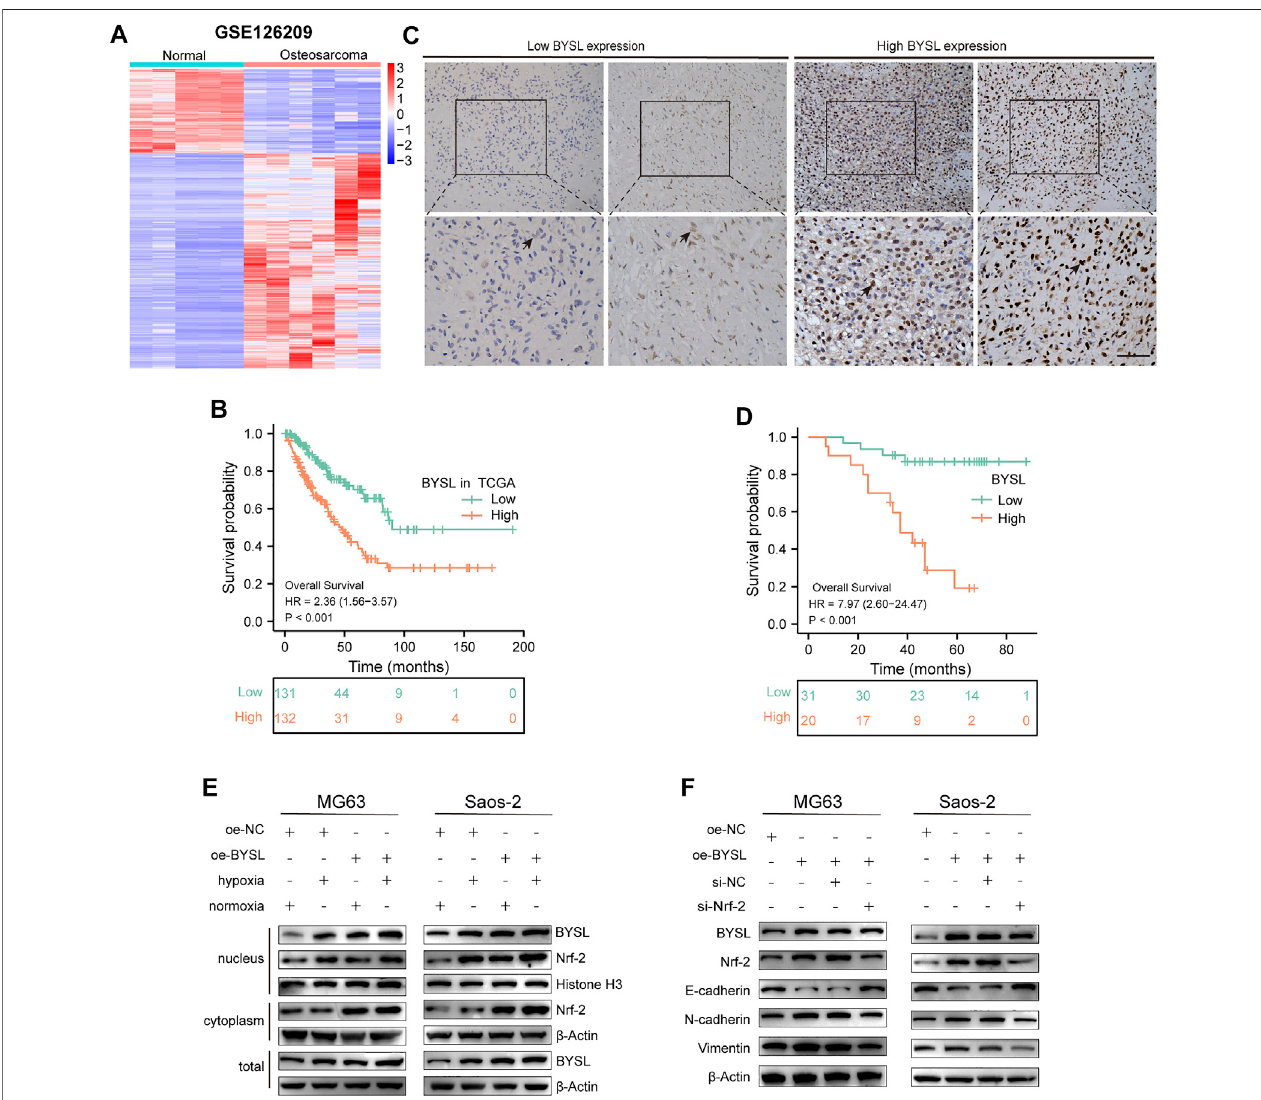
FIGURE1 | BYSL is related to thepoor prognosisof patients with osteosarcoma. (A) Cluster heatmap ofdifferentially expressed genesin GSE126209. (B) Overall survival was compared between osteosarcoma patients with high and low BYSL expression in TCGA database. (C) Immunocytochemical staining of BYSL in osteosarcomatissues( n (cid:1) 51,scalebar (cid:1) 50 µm). (D) Overallsurvivalwascomparedbetweenosteosarcomapatientswithhighandlow BYSL expressioninanin-house cohort. (E) MG63andSaos-2cellsweretransfectedwiththecontrolplasmid(oe-NC)orBYSLoverexpressionplasmid(oe-BYSL),andthenculturedunderhypoxic or normoxic conditions. After nuclear and cytosolic separation, protein levels of Nrf2, BYSL, Histone H3, and β -Actin were measured by western blot. (F) MG63 and Saos-2 cells were transfected with control plasmid (oe-NC), BYSL overexpression plasmid (oe-BYSL), si-control (si-NC), or si-Nrf2, and then cultured under hypoxic condtions. The protein levels of Nrf2, E-cadherin, N-cadheirn, Vimentin, and β -Actin were measured by western blot.